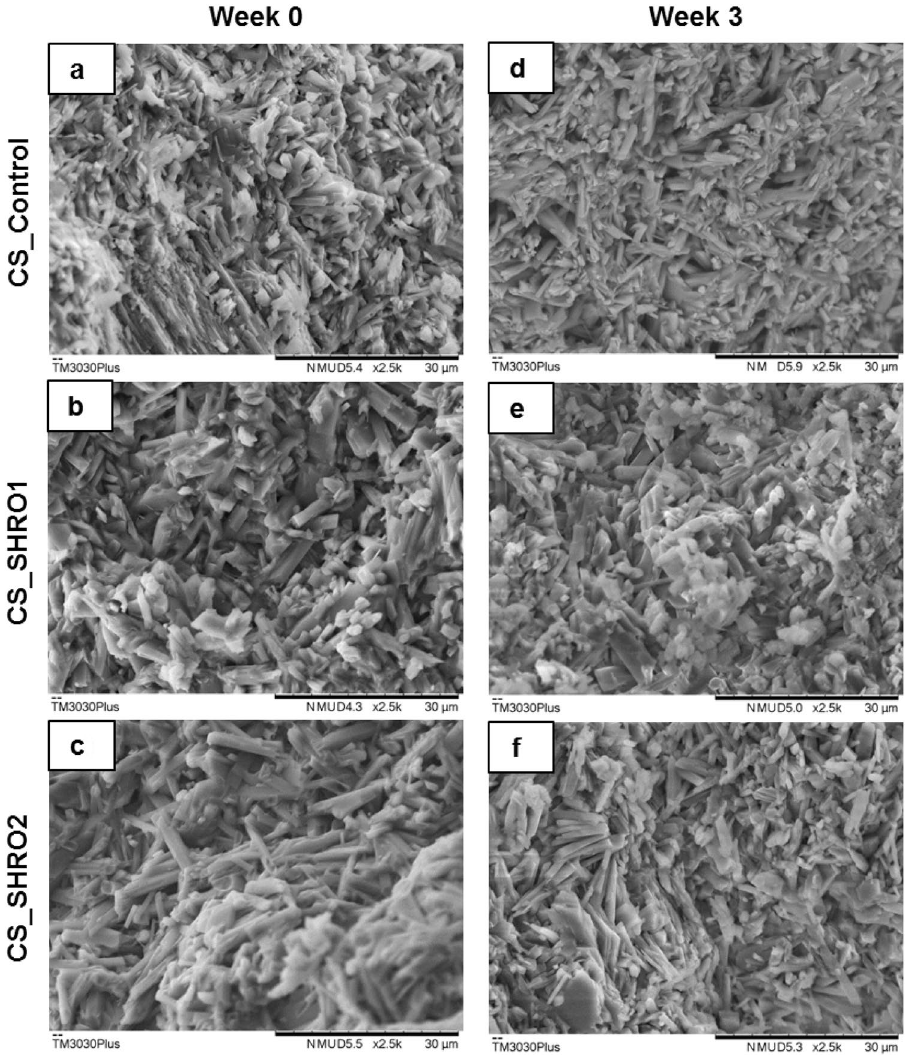
Figure 4. SEM images of ( a ) CS_Control, ( b ) CS_SHRO1 and ( c ) CS_SHRO2 cement fracture surfaces as prepared (Week 0), and ( d ) CS_Control, ( e ) CS_SHRO1 and ( f ) CS_SHRO2 cement fracture surfaces following 3 weeks of static ageing in distilled water (Week